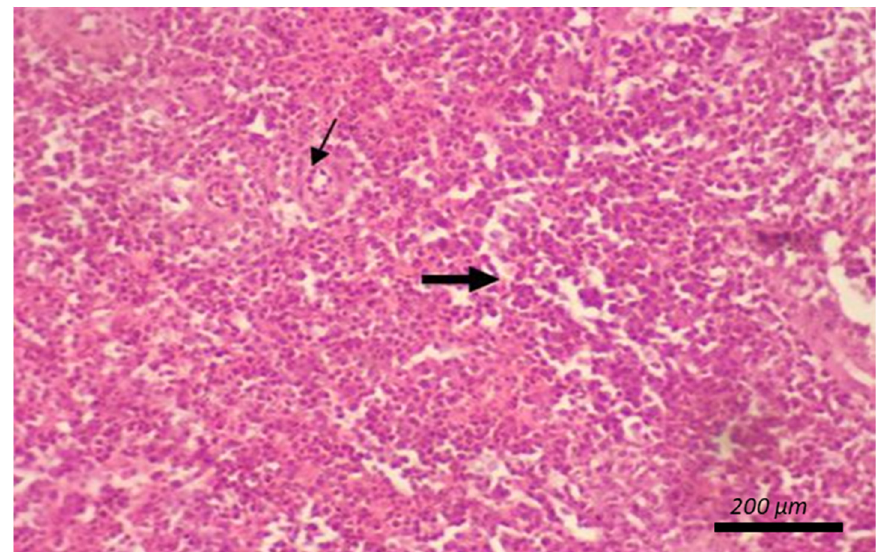
Figure 2. Micrograph of the thymus stained with HandE (X40) to explore the thymic cortical: me- dullary ratio.